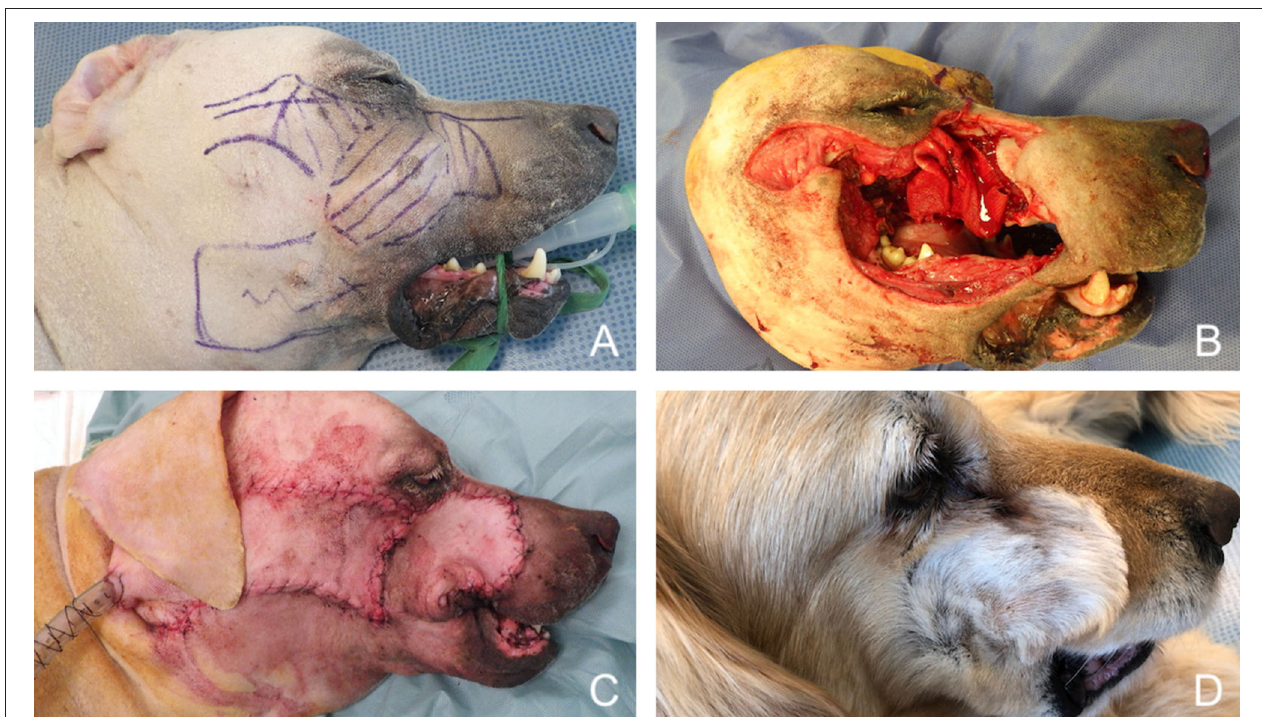
FIGURE 14 | Reconstruction of a composite defect of the mid face with a facial (angularis oris) myocutaneous flap. (A) Surgical planning of the surgery delineating the surgical limits (oblique dash line) and the outline of the flap. (B) Composite resection of the orbitozygomaticomaxillary area in a dog presenting with an osteosarcoma. (C) Immediate postoperative appearance. (D) 4-months postoperative